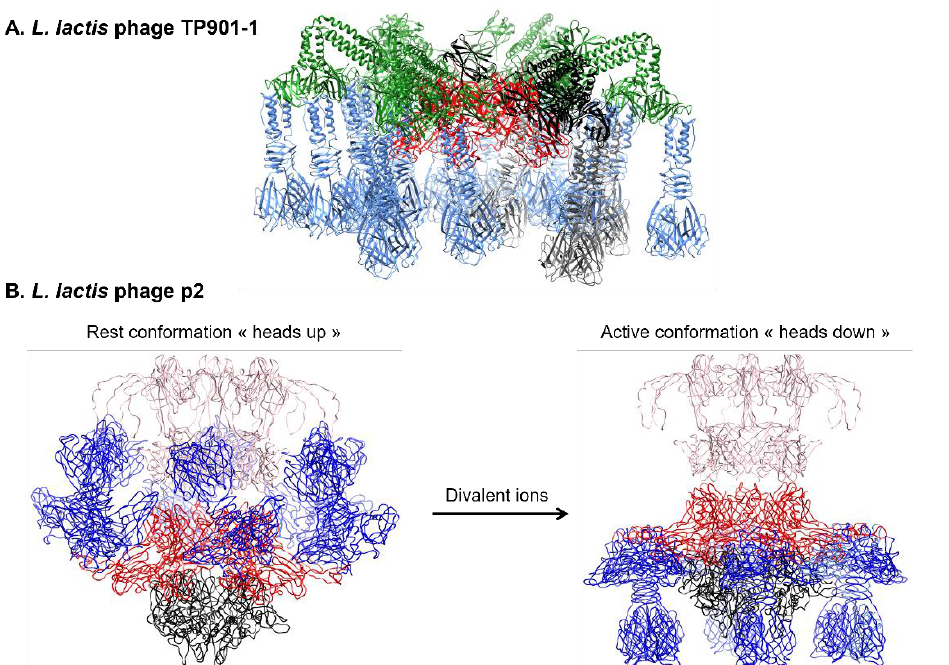
Figure 6. Baseplate conformation of siphoviruses. ( A ) Phage TP901-1 has a “ready-to-infect” baseplate, which is formed by a Dit hexamer (red) on which are anchored six trimeric BppU (green), each attaching three RBP trimer (blue). One tripod is formed by one BppU attaching three RBP and is highlighted in a different shade of black. The Tal trimer attaching at the bottom of the baseplate is missing. ( B ) In presence of divalent cation, phage p2 baseplate switches from a “rest” conformation, where RBP point upwards toward the capsid, to an “active” conformation where the RBP face down. The trimeric Tal (black) and the six RBP trimers (blue) are attached to a hexameric Dit (dark red). In phage p2, a second Dit hexamer is found in the baseplate (pink). Structures were retrieved from the Protein Data Bank (TP901-1 baseplate: PDB ID 4V96 and [91]; p2 baseplate rest: PDB ID 6ZJJ and [120]; p2 baseplate active: PDB ID 6ZIH and [120]).